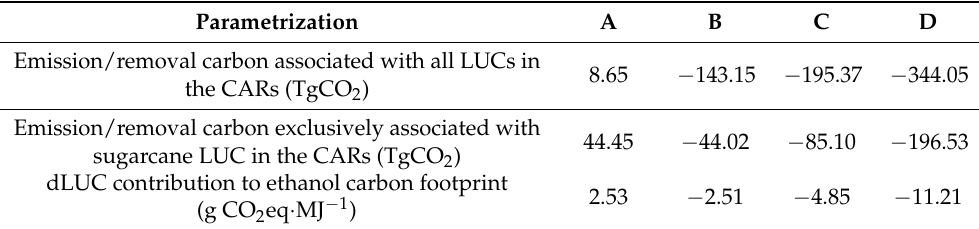
Figure 11. Total annual net emissions/removals (MgCO 2 ∙ yr − 1 ) in parametrization D for each CAR in 2000–2020 due to ( a ) all LUC that occurred only within CARs and ( b ) the LUC that occurred only in sugarcane areas in 2020 within CARs.